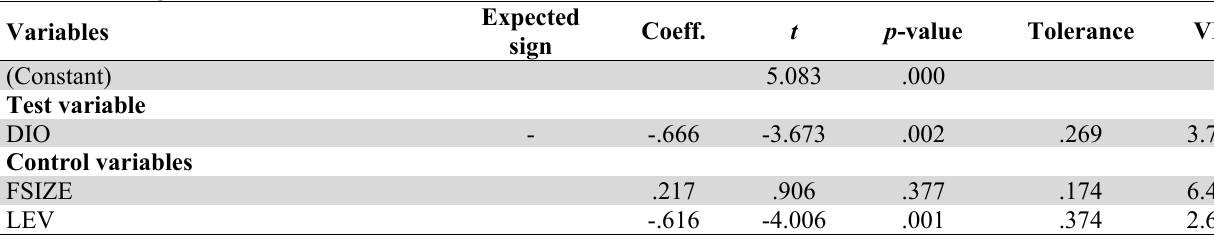
Pooled OLS regression – Model 2- ROE Variables Test